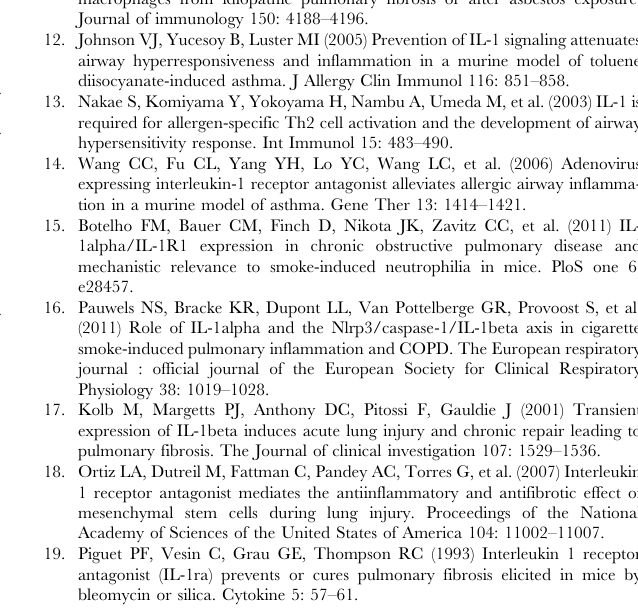
Figure S1 Intratracheal instillation of IL-36 a induced neutrophil influx in the lungs of endotoxin resistant C3H/HeJ mice. A) Total cell counts from BAL fluid recovered from mice 24 h following a single i.t. instillation of PBS or 10 m g IL-36 a . C) Differential cell count percentages and D) Differential cell count numbers in the BAL fluid recovered from mice 24 h following a single i.t. instillation of PBS or 10 m g IL-36 a . *Indicates significant differences ( P , 0.05 ) compared to PBS treated mice. Data represent mean 6 SEM from 4–5